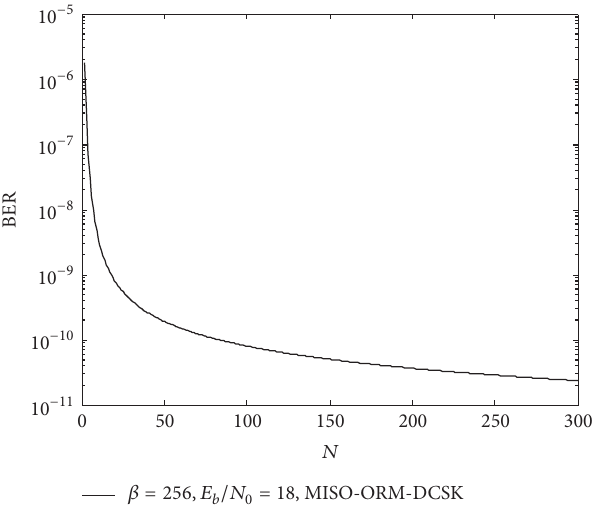
Figure 8: Relationships between BER and 𝑁 for MISO-ORM- DCSK.